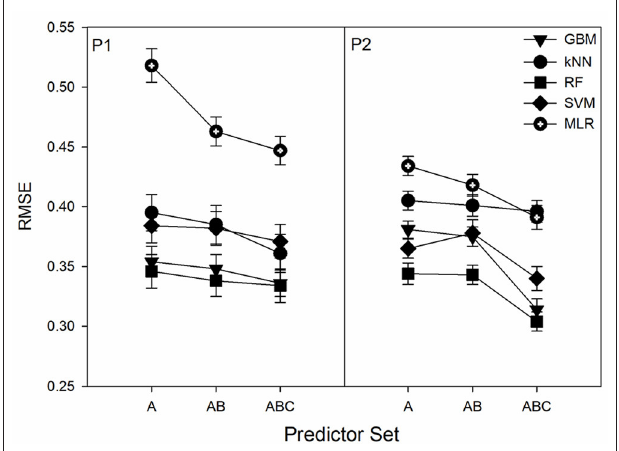
FIGURE 2 | Dependence of the root-mean-squared error (RMSE) on the predictor set size. Predictor sets have 5, 8, and 12 predictors for A, AB, and ABC, respectively. Displayed results are from the 2018